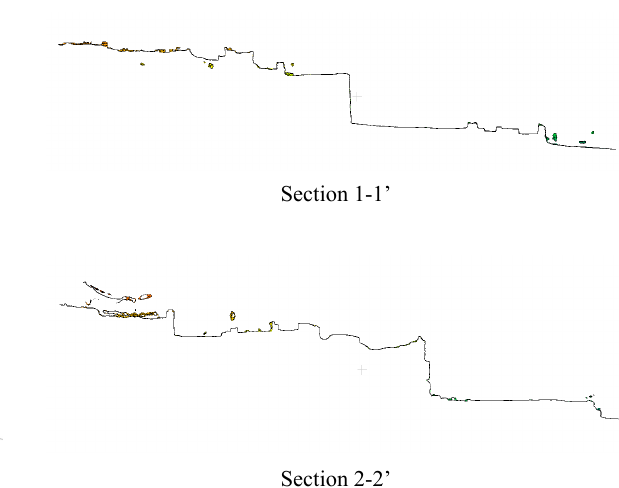
Figure 13. Two-dimensional plan of the district (from Iaocomi, 2013, drawing by B. Braini)